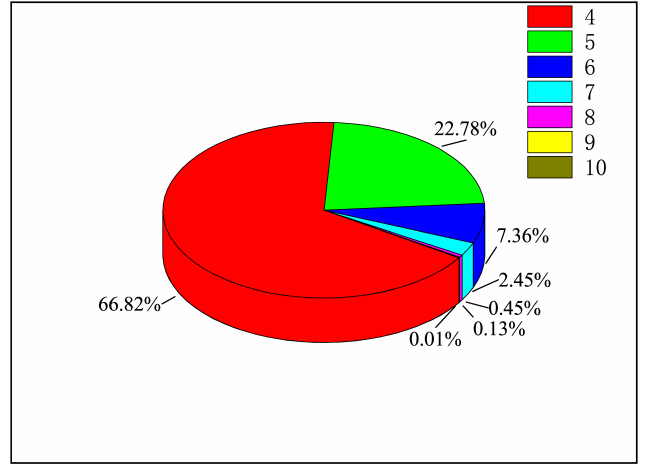
Figure 11. The proportions of nl ( n = 4 − 10) energy levels to the total cross-section in EA processes of the ground state W 40 + .